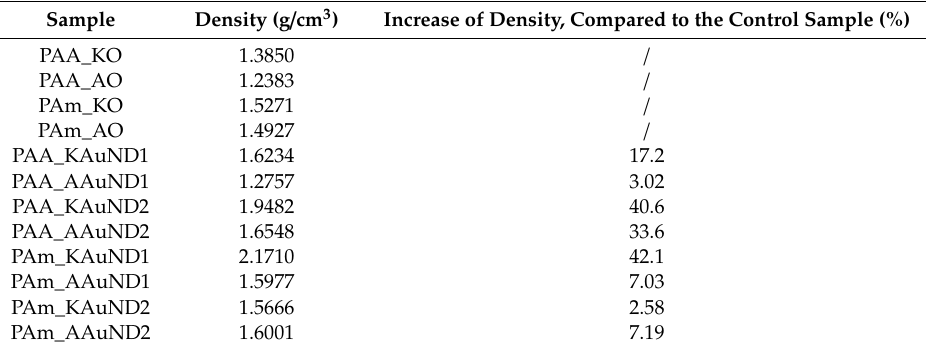
Table 3. Densities of prepared control samples and polyacrylate-AuNPs’ composites.